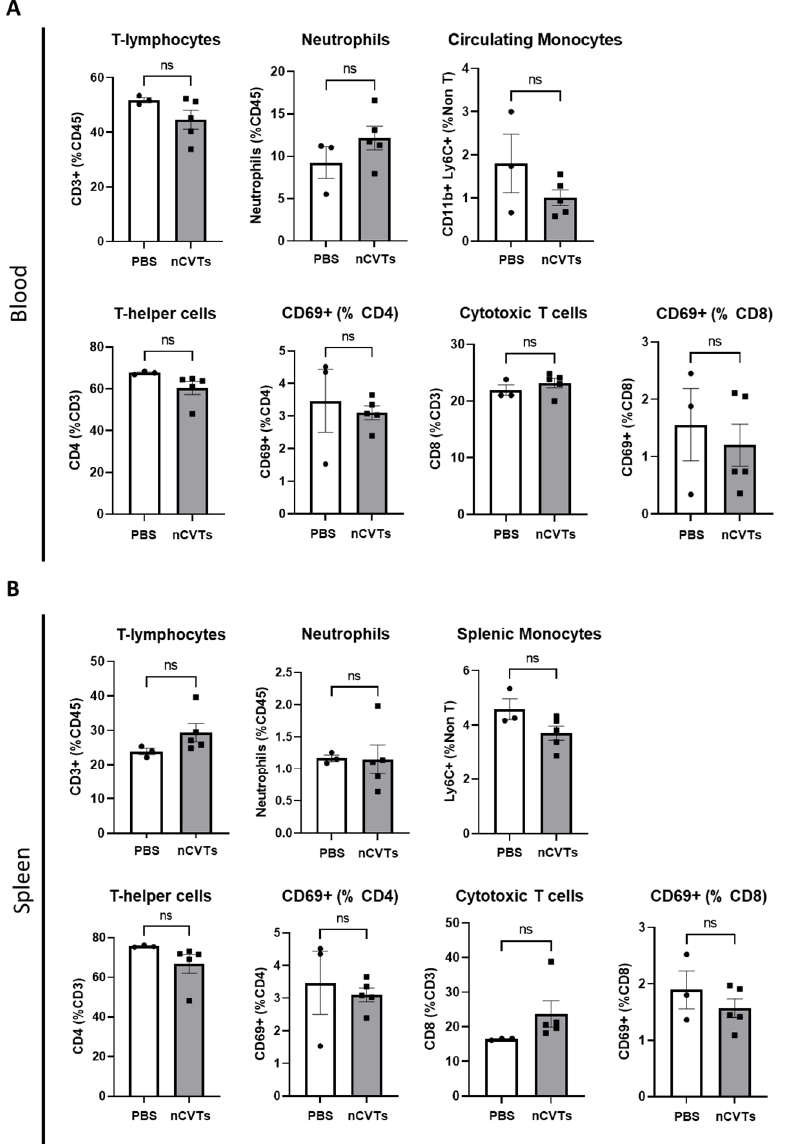
Figure 3. Immune cell profiles in the ( A ) blood and ( B ) spleen ( n = 3 for PBS group; n = 5 for nCVTs group) . ns indicates not significant ( p > 0.05).